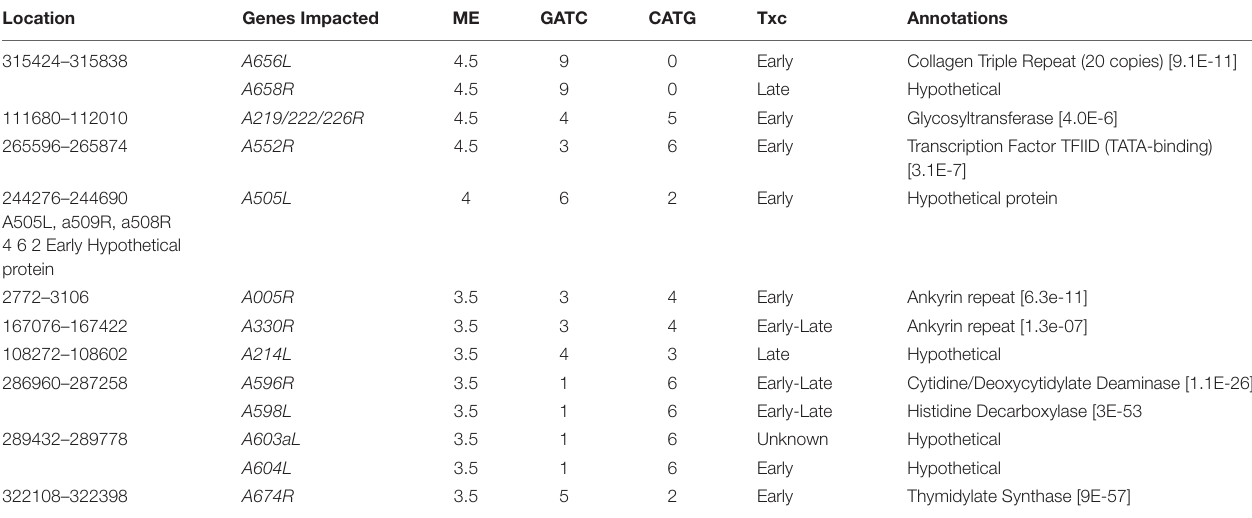
TABLE 2 | Top ten PBCV-1 genomic regions enriched in GATC and/or CATG motifs using a sequence independent 278 bp window.